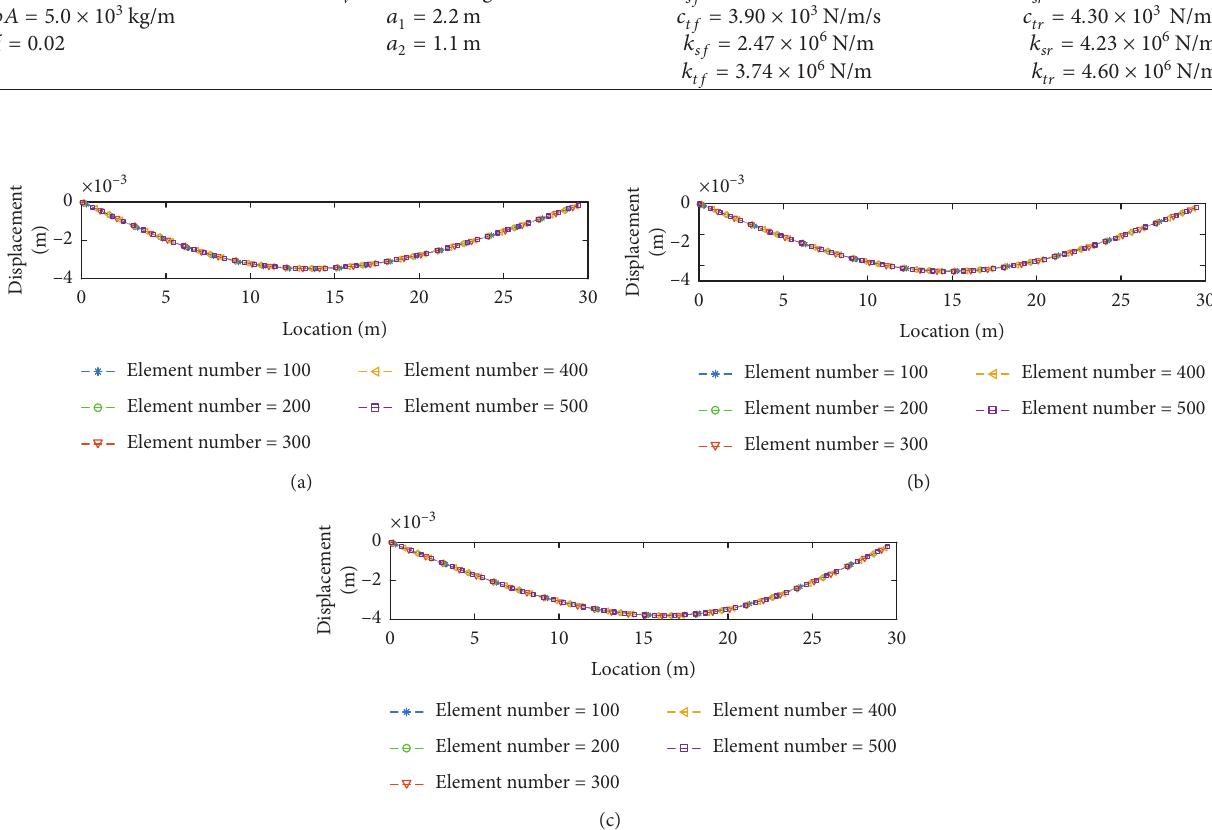
Figure 13: Bridge displacement x bridge location (m) and y displacement (m). (a) Front wheel at L /3. (b) Front wheel at L /2. (c) Front wheel at 2 L /3.